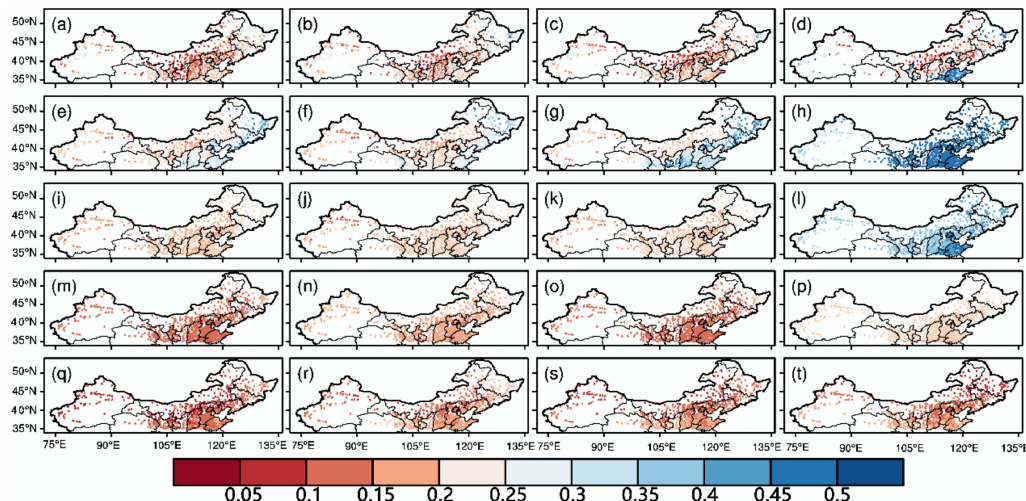
Figure 6. Spring ( a , e , i , m , q ), summer ( b , f , j , n , r ), autumn ( c , g , k , o , s ), and winter ( d , h , l , p , t ) Soil moisture observations and the median spatial distribution of different soil moisture products (Unit: m 3 · m − 3 ). ( a – d )—observation; ( e – h )—AMSR2 product; ( i – l )—CCI product; ( m – p )—SMAP product; ( q – t )—SMOS product.